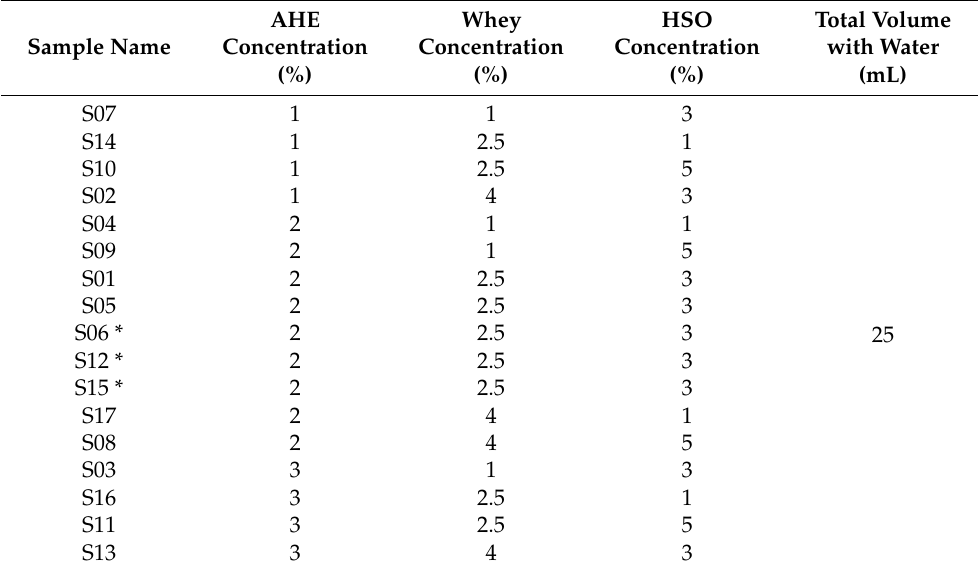
Table 1. Box–Behnken design samples description; AHE— Aesculus hippocastanum L. extract; HSO— hempseed